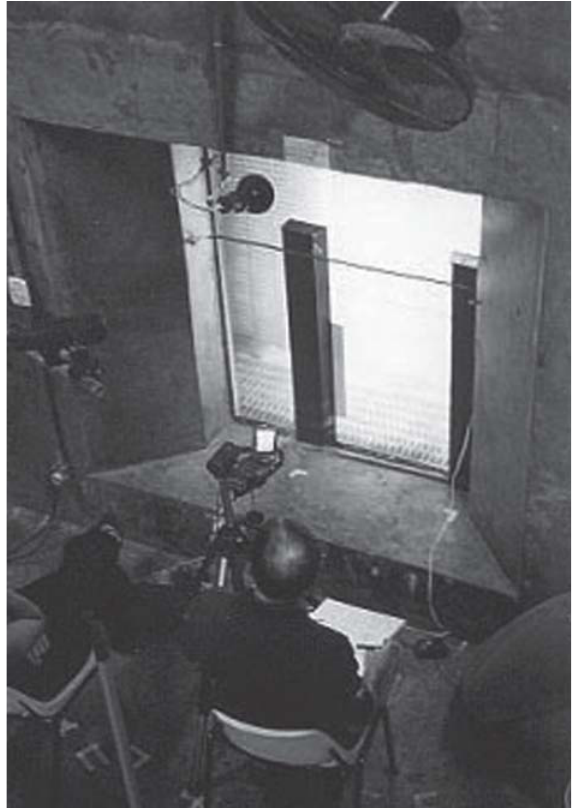
Fig. 1. Camera configuration with Sony Camera (DCR-TRV950) in frame center. The two vertically oriented full spectrum lights are adjacent to the window; above is the infrared light